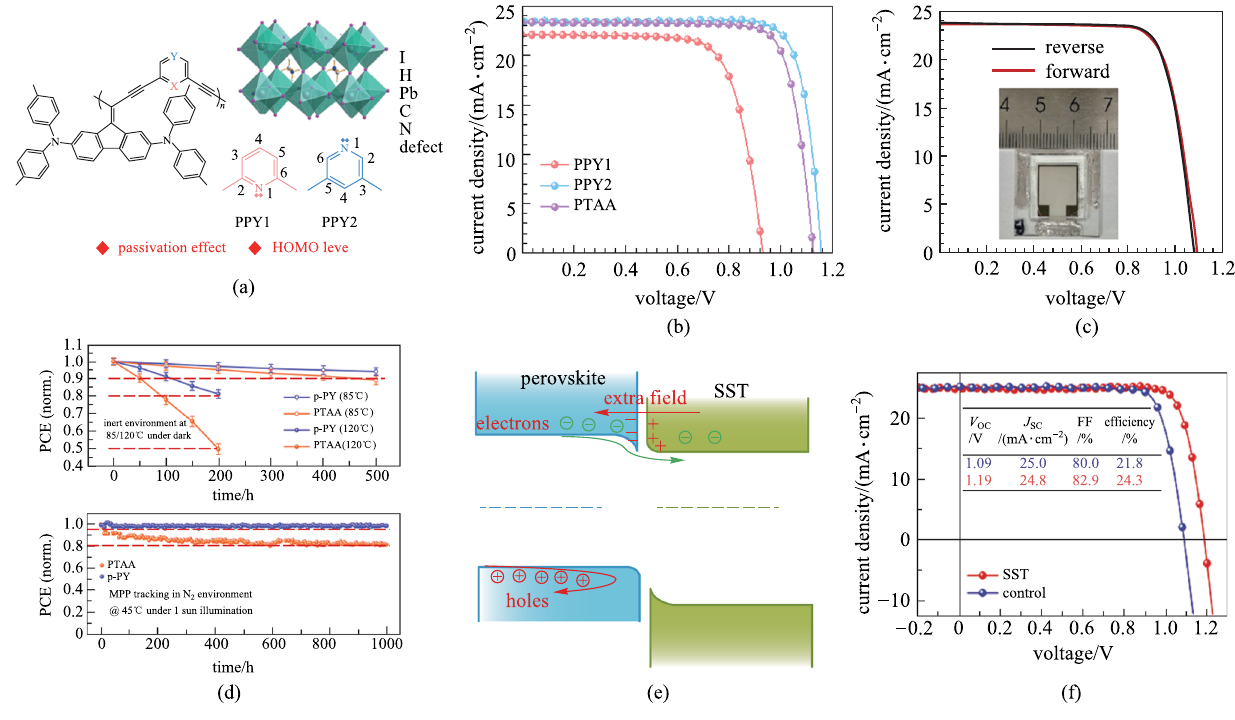
Fig. 5 a Molecular design strategy of PPYs . b J – V curves of the champion PVSCs based on dopant-free PPY1 - 2 and PTAA . c Schematic illus- tration of the device structure based on p-PY . d Thermal stability of the unencapsulated devices stressed at 120 °C in N 2 atmosphere in the dark, and light soaking stability of unencapsulated devices under 1 sun equivalent white light LED array illumination with continuous MPP tracking at 45 °C in N 2 atmosphere. e Back-surface field formation at the perovskite surface with surface sulfidation treatment (SST). f J – V curves of control and SST-based PVSCs. a , b Reprinted with permission from Ref. [50]. Copyright 2021, WILEY–VCH Verlag GmbH & Co. KGaA,